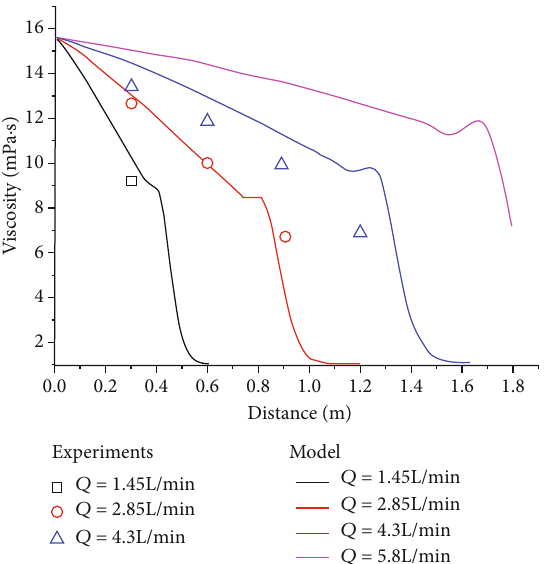
Figure 14: Variation in the viscosity of the e ffl uent versus the distance under di ff erent fl ow rates ( WCR = 1 : 5 , t = 60s